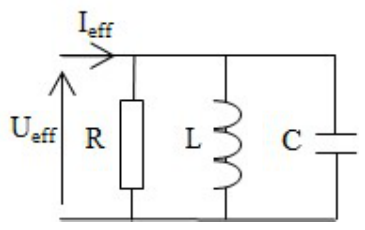
Figure 3. RLC parallel circuit simulated.